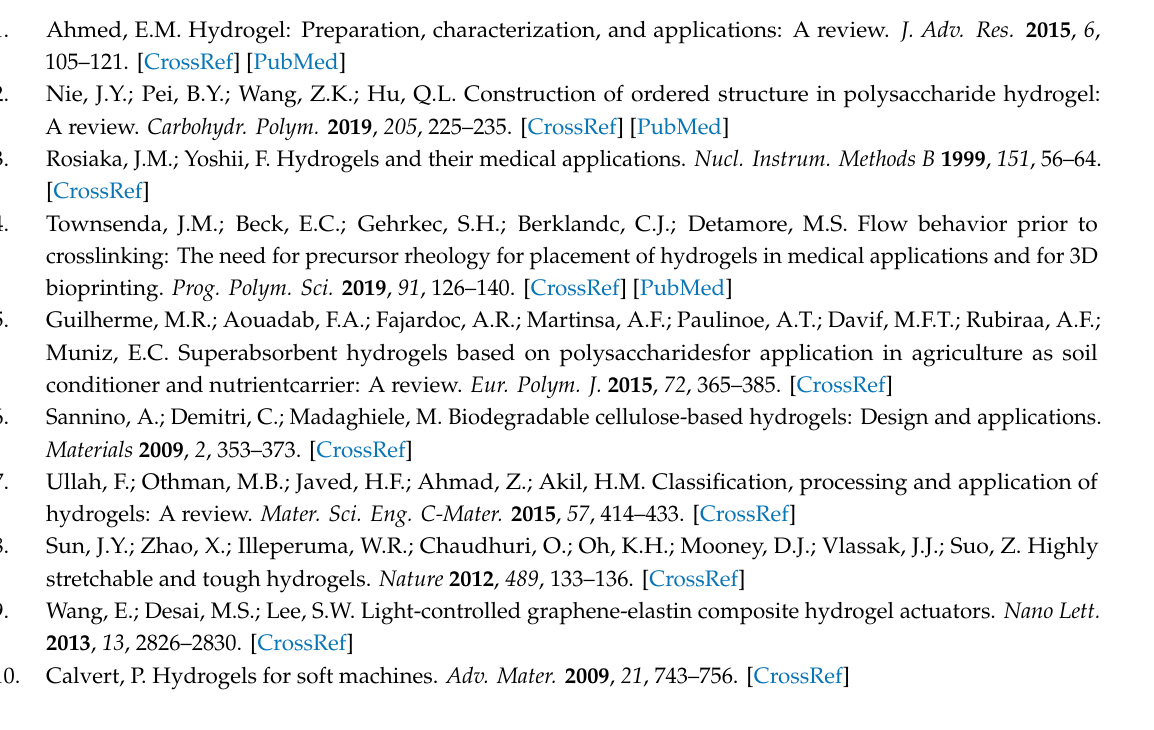
Figure S1: Variation of mass ratio with immersing time of porous PU hydrogels in di ff erent TA solutions. Error bars indicate standard deviation; N = 3. Figure S2: Variation of mass ratio with immersing time of porous TA10–PU hydrogel in distilled water. Error bars indicate standard deviation; N = 3. Figure S3: XRD graphs of PU and TAx–PU(S) dry gels. Figure S4: Swelling curves of PU(S) and TAx–PU(S) hydrogels. Figure S5: Images of adhesion test of TA30–PU(S) hydrogel. Figure S6: Tensile stress–strain curves of pristine and self-healed TA30–PU(S)